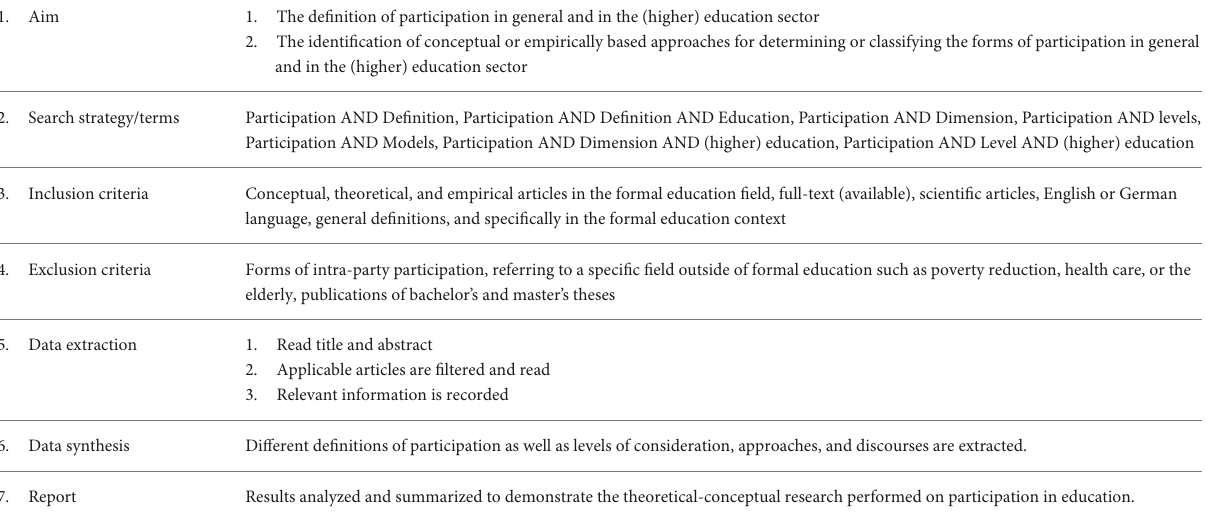
TABLE 1 Process of representative literature review (cf. Schad and Jones, 2019, p.